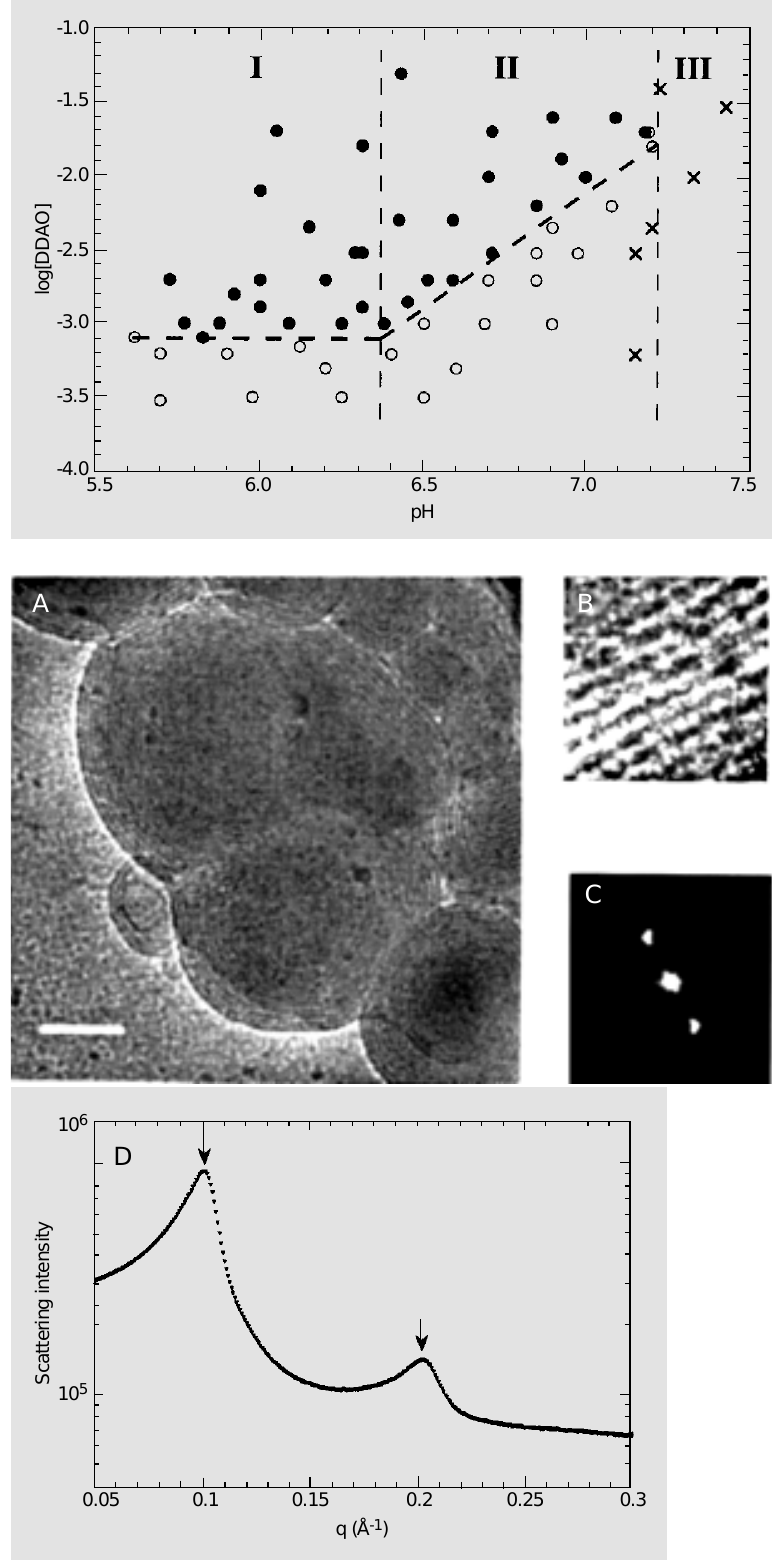
Figure 10. Phase map of the T4 DNA-dodecyldimethyl- amine oxide (DDAO) system at 25 (cid:1) C in 50 mM NaCl obtained with fluorescence microscopy at various pH values of the surfactant solution (as measured before mixing with DNA). Coil T4 DNA molecules are repre- sented by crosses, the coexistence of unfolded and condensed T4 DNA molecules is represented by open circles, and the compact globular state of all DNA mol- ecules by closed circles. Reprinted from Ref. 33, with permission.